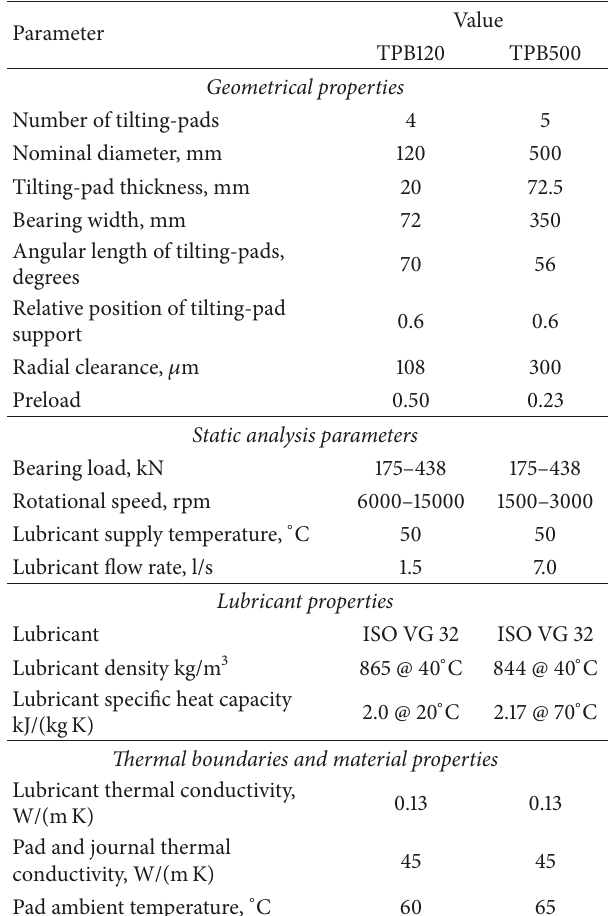
Table 1: Key parameters of analysis.